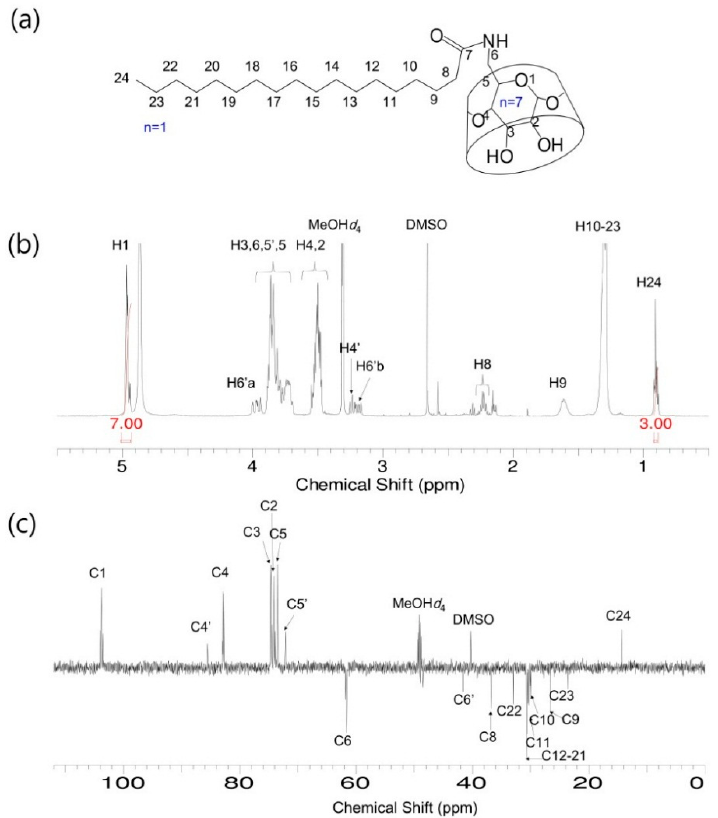
Figure 2. S- β -CD. ( a ) Chemical structure; ( b ) 1 H-NMR spectrum; and ( c ) DEPT-135 NMR spectrum. Solvent: MeOH- d 4 .